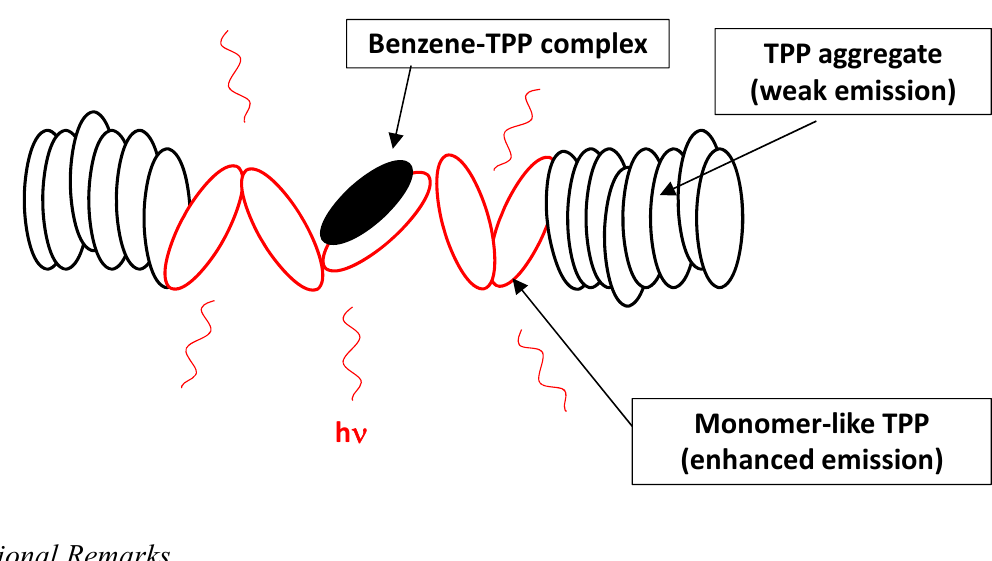
Figure 17. Illustration of Benzene-TPP complex formation in TPP aggregates. Modified version from